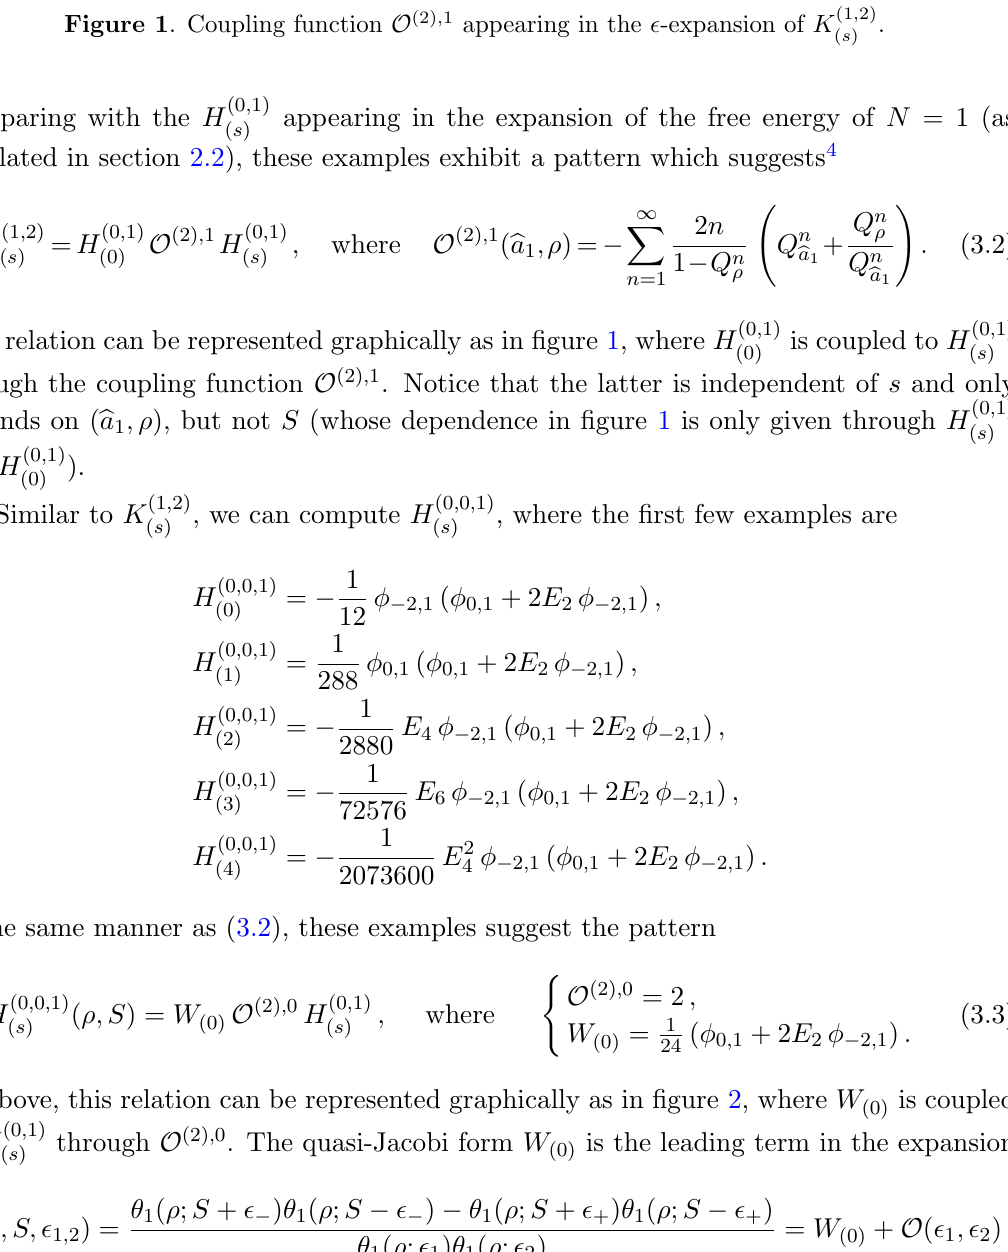
Figure 1 . Coupling function O (2) ; 1 appearing in the (cid:15) -expansion of K (1 ; 2)